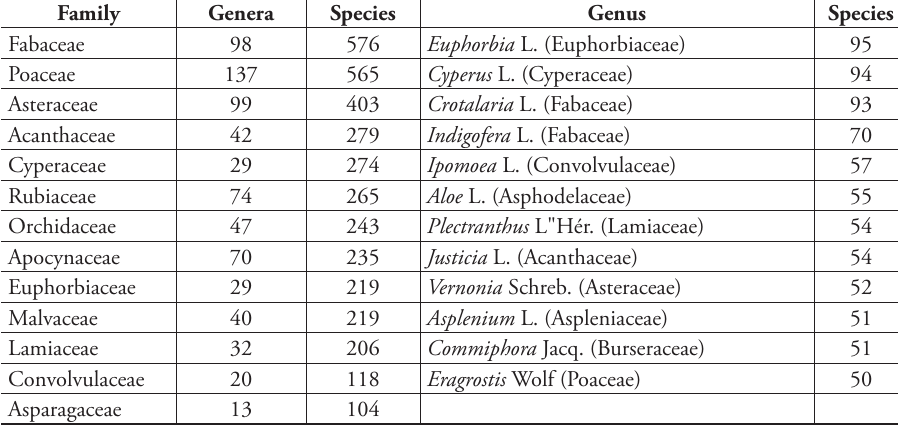
Table 1. The 13 largest families with more than 100 species, and the 12 largest genera with more than 50 species.